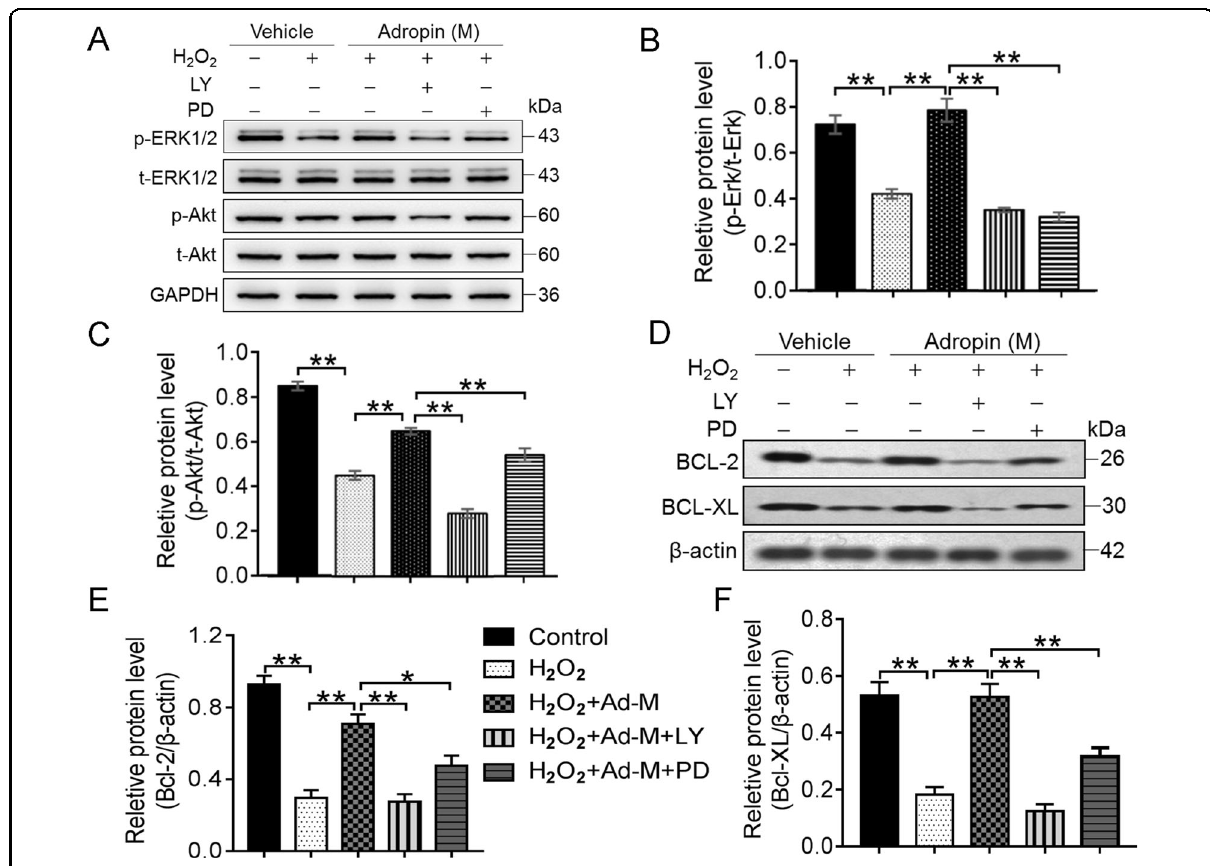
Fig. 1 In vitro antiapoptotic effects on H 2 O 2 -induced apoptosis of bone marrow MSCs by adropin through activating the PI3K/Akt and ERK1/2 pathways. The antiapoptotic proteins BCL-2 and BCL-XL, and both total and phosphorylation levels of Akt and ERK1/2 were assessed in H 2 O 2 -injured MSCs by western blotting. Typical graphs of western blotting were shown in ( A , D ). B , C , E , F Quantitative western blotting analysis. MSCs Mesenchymal stem cells. H 2 O 2 Hydrogen peroxide. Ad-M Moderate dose of adropin (25 ng/ml). LY LY294002. PD PD98059. p- Phosphorylation. t- Total. ERK1/2 Extracellular regulated protein kinase 1/2. PI3K Phosphatidylinositol 3-kinase. BCL-2 B-cell lymphoma-2. BCL-XL B-cell lymphoma-extra large. * p < 0.05; ** p <